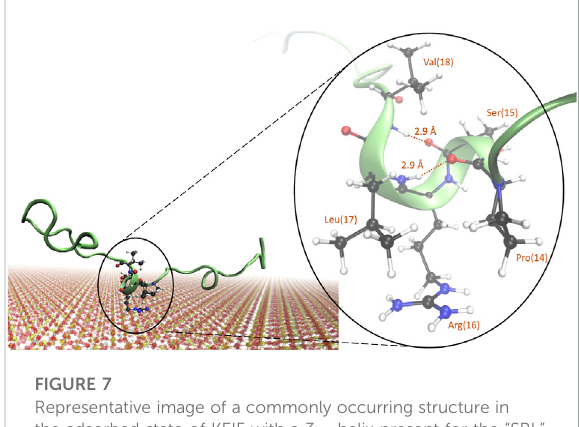
Representative image of a commonly occurring structure in the adsorbed state of KEIF with a 3 10 -helix present for the “ SRL ” sequence. Atoms are shown for the “ PSRLV ” sequence, with the hydrogen bonds and distances